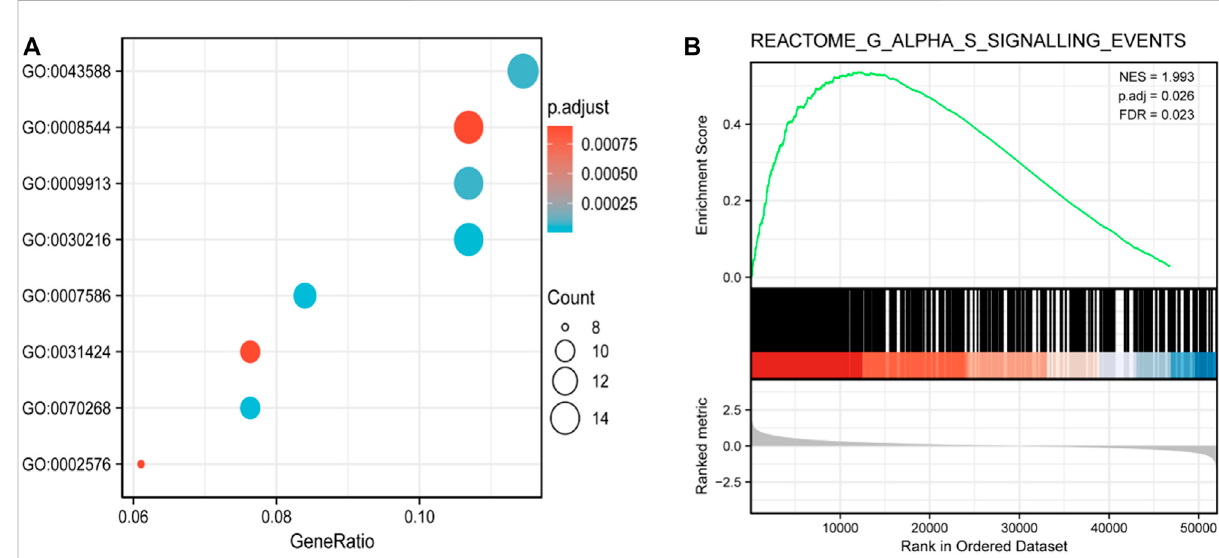
FIGURE 2 Functional enrichment analysis of DEGs between RPP30 high and RPP30 low groups of GC in TCGA. (A) Enriched GO terms in the biological process category. The x -axis represents the proportion of DEGs, and the y -axis represents different categories. In this category, skin development (GO: 0043588), epidermis development (GO: 0008544), epidermal cell differentiation (GO:0009913), and keratinocyte differentiation (GO: 0030216) were primarily enriched. (B) GSEA results showed that the G alpha S signaling pathway was the most enriched. (NES, normalized enriched score; P . adj, adjusted p -value; FDR, false discovery rate; gene sets with P . adj < 0.05, FDR q-value < 0.25, and |NES| > 1 are considered as signi fi cant).